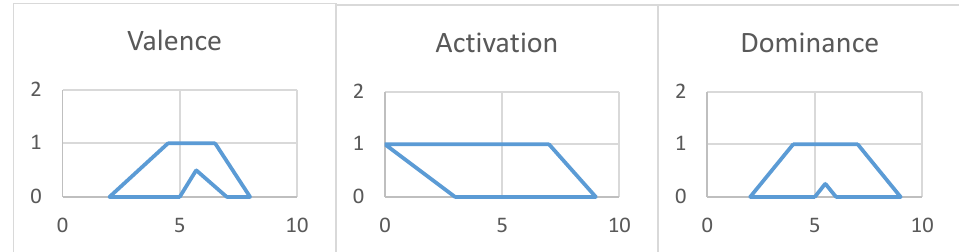
Fig. 9. The FOU of Onuma (Wrath) for dimensions valence, activation and dominance.